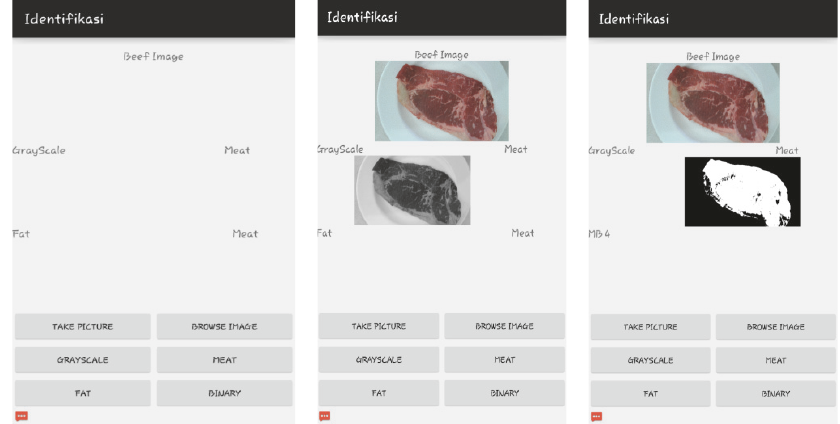
Figure 9: System embedding into